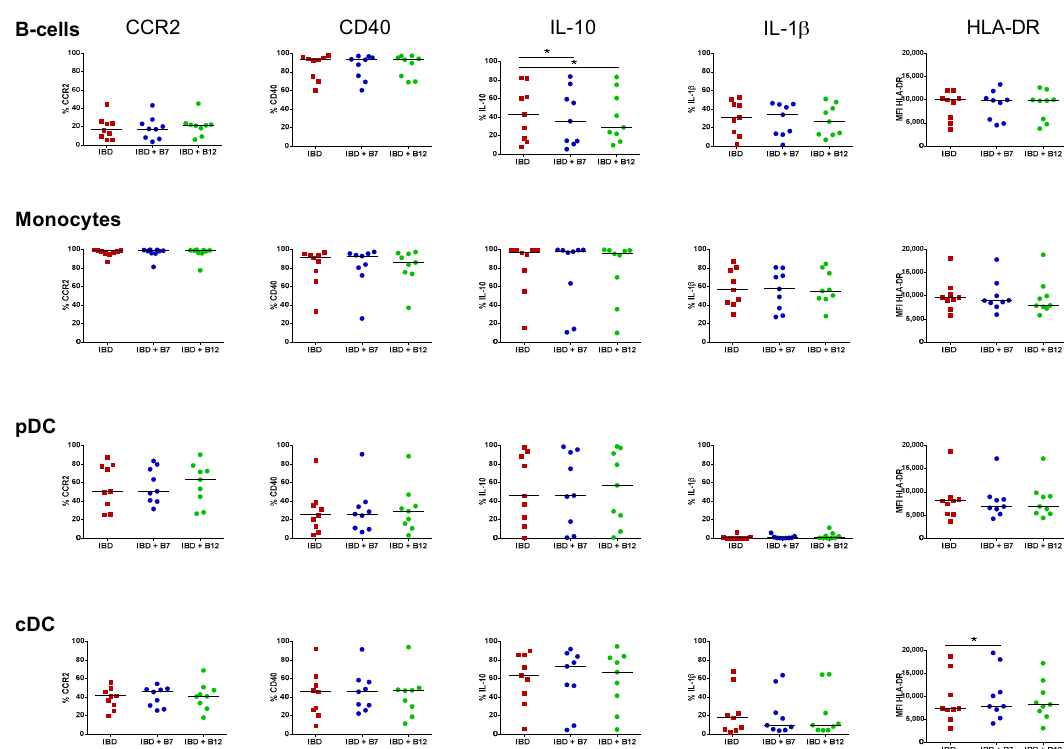
Figure 4. Immunomodulatory effect of bacterial peptides over circulating antigen presenting cells from patients with inflammatory bowel disease. The effect of bacterial peptides B7 and B12 over the phenotype and cytokine production of B-cells, monocytes, plasmacytoid dendritic cells (pDCs), and conventional dendritic cells (cDCs) from patients with inflammatory bowel disease (IBD) was determined. Cell subsets were identified as in Figure 2, and characterized following overnight culture in the absence (IBD) and presence of bacterial peptides B7 (IBD + B7) and B12 (IBD + B12). Results are expressed as percentage of positive cells (%) for CCR2, CD40, IL-10, and IL-1 β or by the median fluorescence intensity (MFI) for HLA-DR in each given subset. The Wilcoxon paired test was applied to determine statistical differences in the levels of each marker within each subset for both peptides versus resting conditions. p -values < 0.05 were considered significant (*).